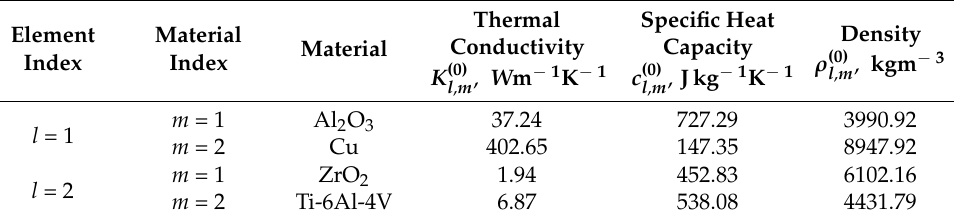
Table 2. Material properties at the initial temperature T 0 .